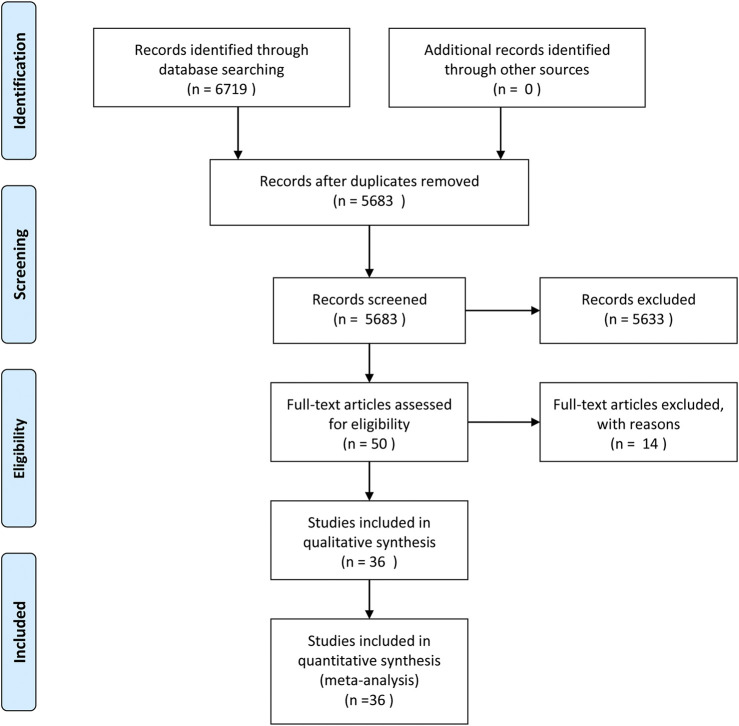
Search strategy.